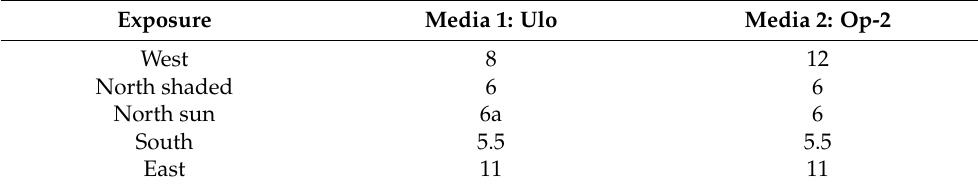
Table 1. The sizes of the 10-cm depth research subplots on building 3 from 2001; on each part of the roofs, the following sized areas were selected for treatments with additional irrigation and fertilizer, and the “normal” comparison plots for the four test plots (in m 2 ). Exposure Media 1: Ulo Media 2: Op-2 West 8 12 North shaded 6 6 North sun 6a 6 South 5.5 5.5 East 11